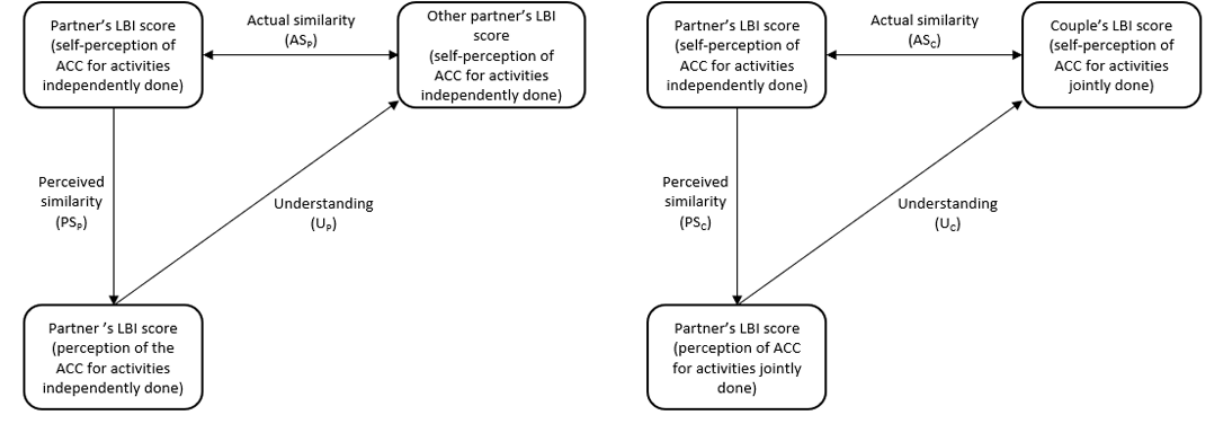
Figure 2. Coefficients of perceptual congruence of time-use patterns among couples that are used for statistical calculations (adapted from the model of Acitelli et al [33]). ACC: activity configuration congruence; LBI: Life Balance